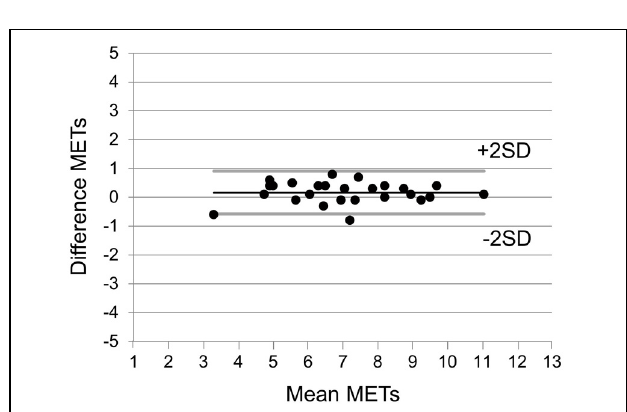
FIGURE 3 | Differences among two measurements performed on each of 26 patients as a function of their mean values for METs.